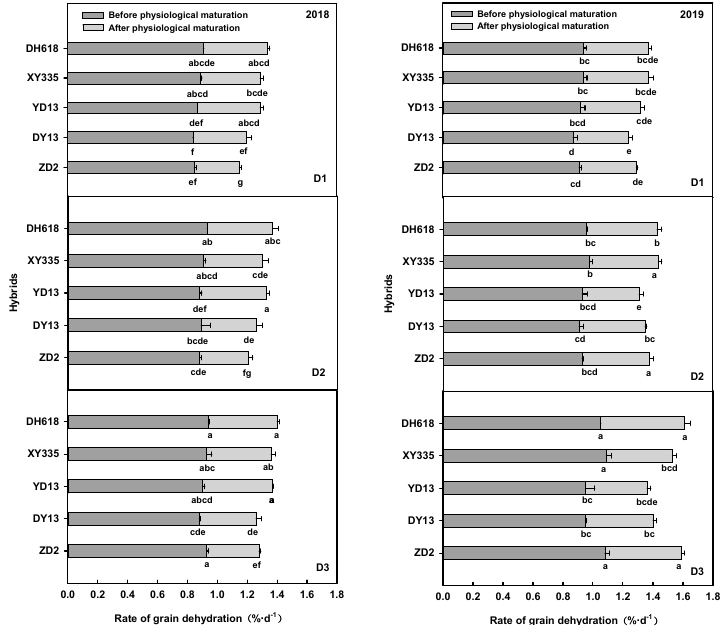
Figure 2. Changes in grain dehydration rate before and after physiological maturity of different cultivars at different densities in 2018 and 2019. Different letters on the graph indicate significant differences at p < 0.05.